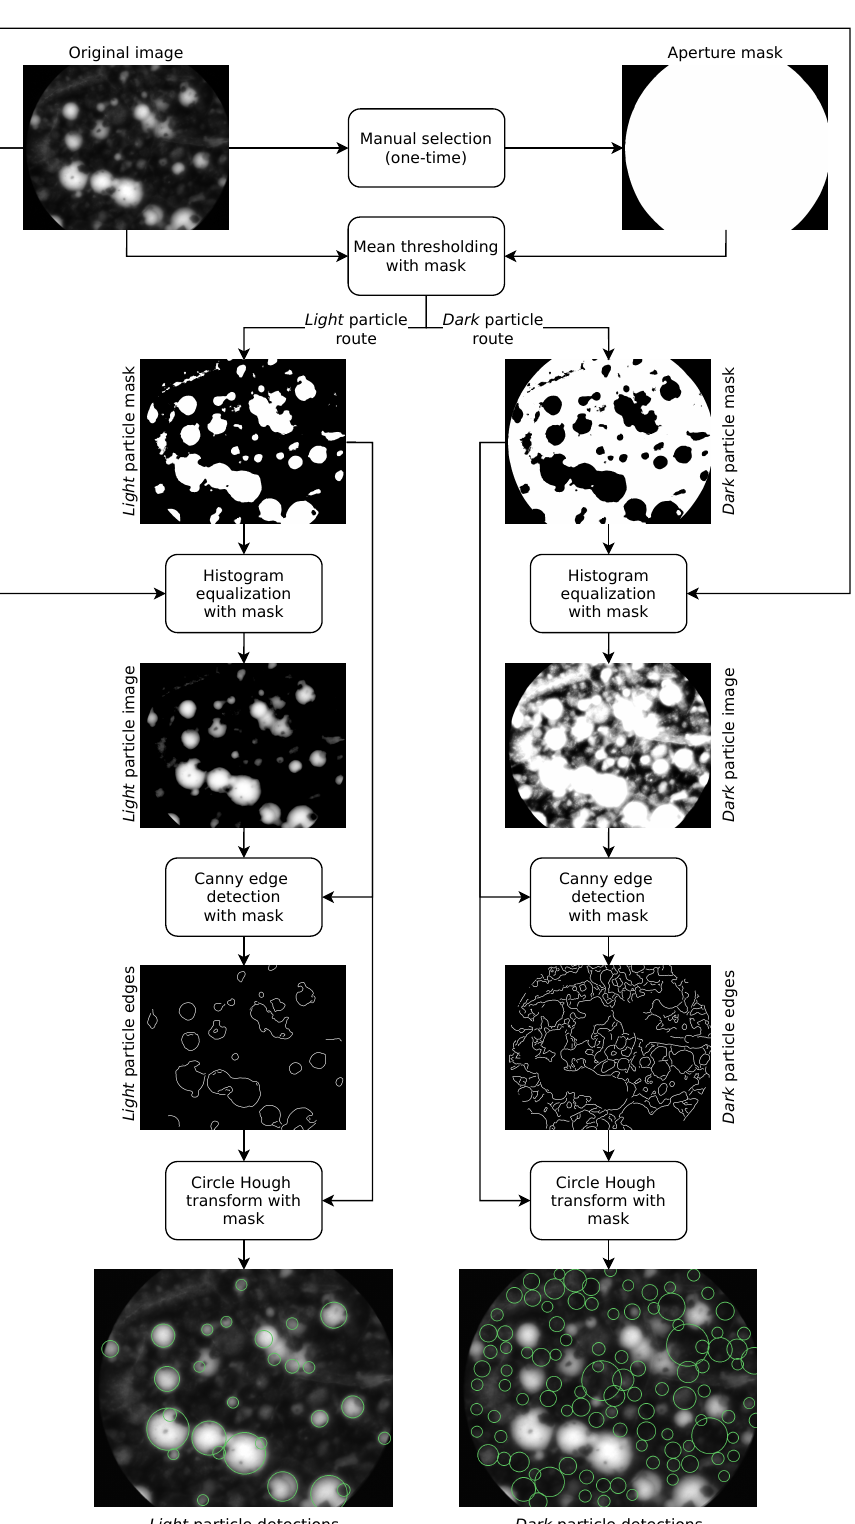
Figure 8. Illustration of conventional fully-automated benchmark method using Hough